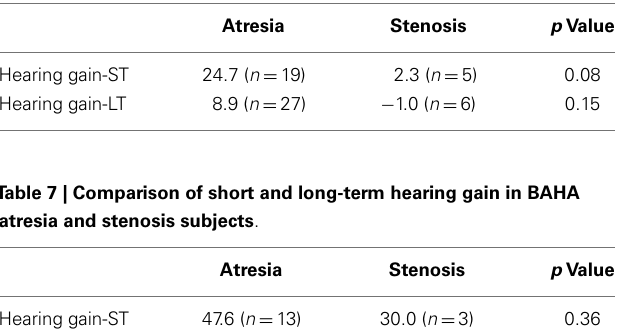
Table 6 | Comparison of short and long-term hearing gain in EACR atresia and stenosis subjects .